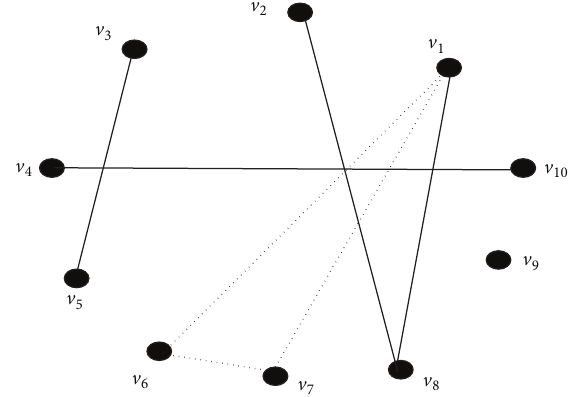
Figure 2: Illustration for the random network with probability 𝑝 = 0.15 for every pair of nodes being connected: 𝑁( V ̃𝑁( V ) = { V , V } 1 6 7